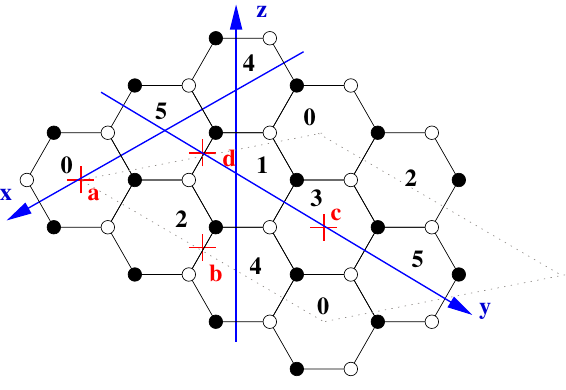
Figure 5 . Dimer diagram for an orientifold of the C 3 = Z 0